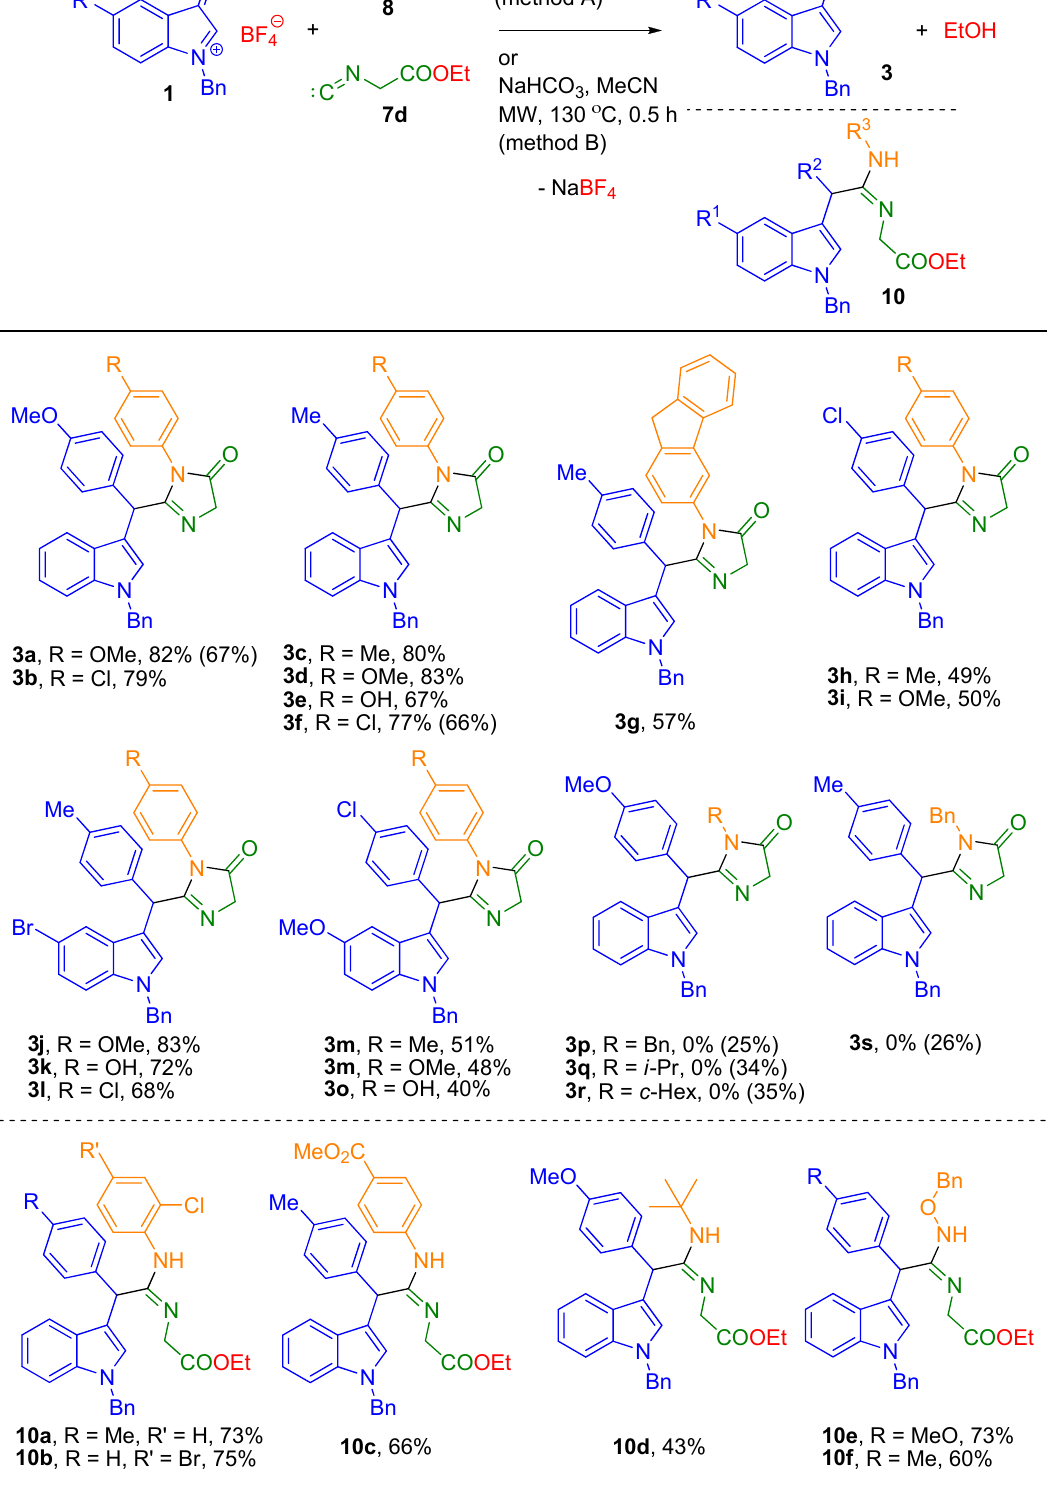
Scheme 5. Reactions of 3-arylidene-3 H -indolium salts 1 with isonitrile 7d and amines 8 . The yields of imidazolones 3 obtained by method B are indicated in parentheses.